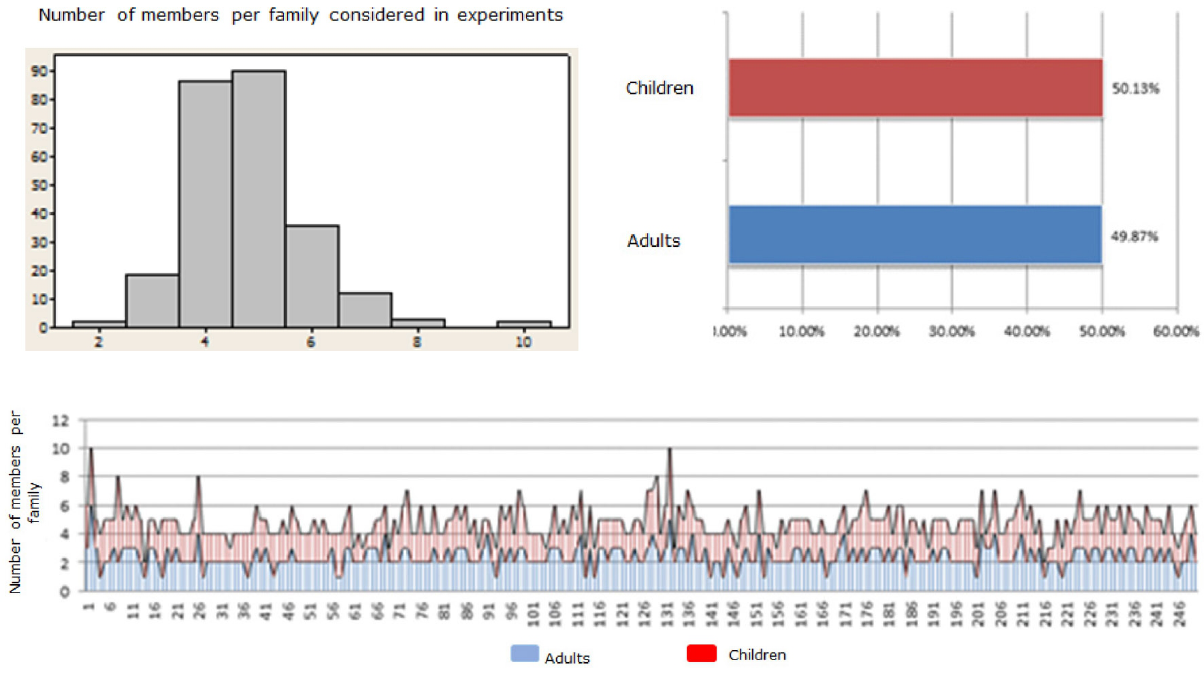
Figure 3. Number of members per family considered in